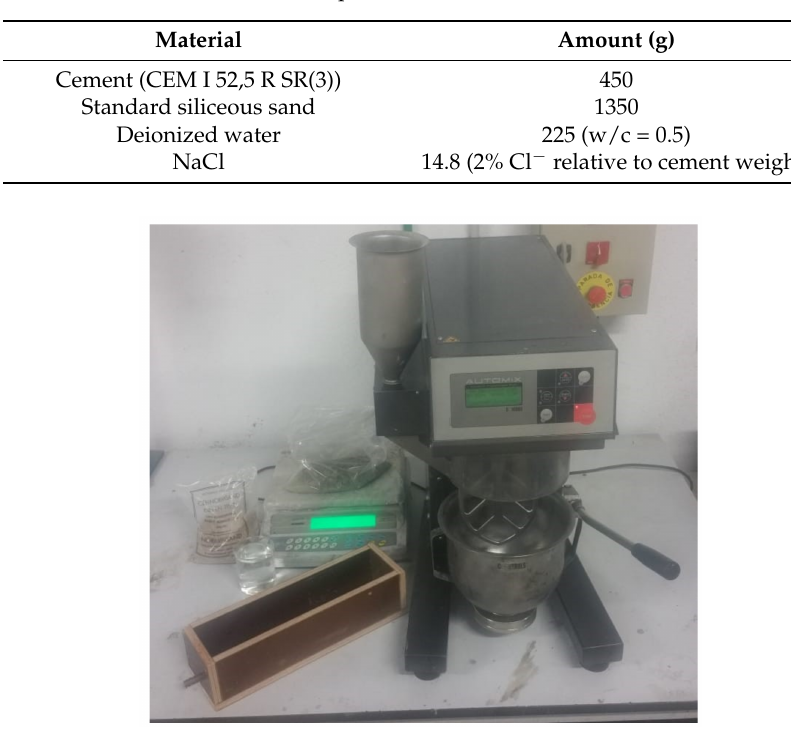
Table 1. Composition of the cement mortar.